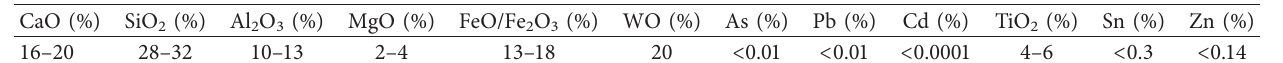
Figure 2: Particle size distribution of crumb rubber powder (CRP) and tin slag (TS). Table 3: Chemical composition of tin slag.